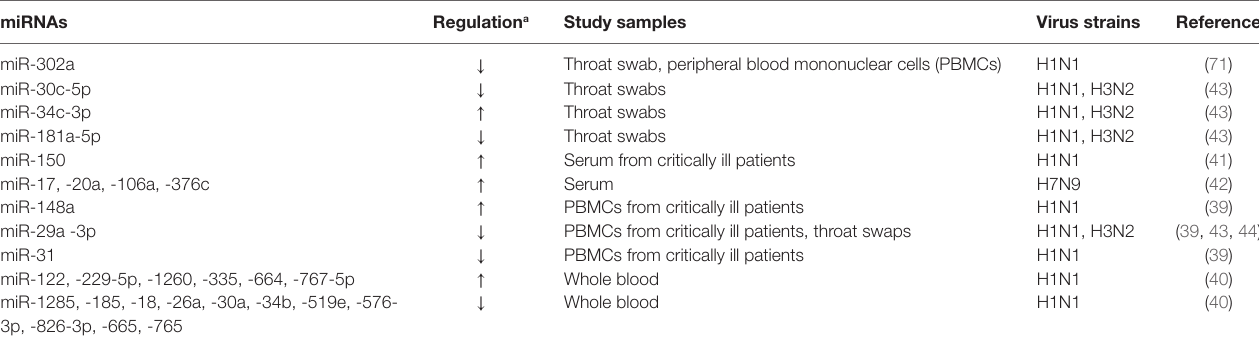
TAble 1 | MicroRNAs (miRNAs) as diagnosis markers.